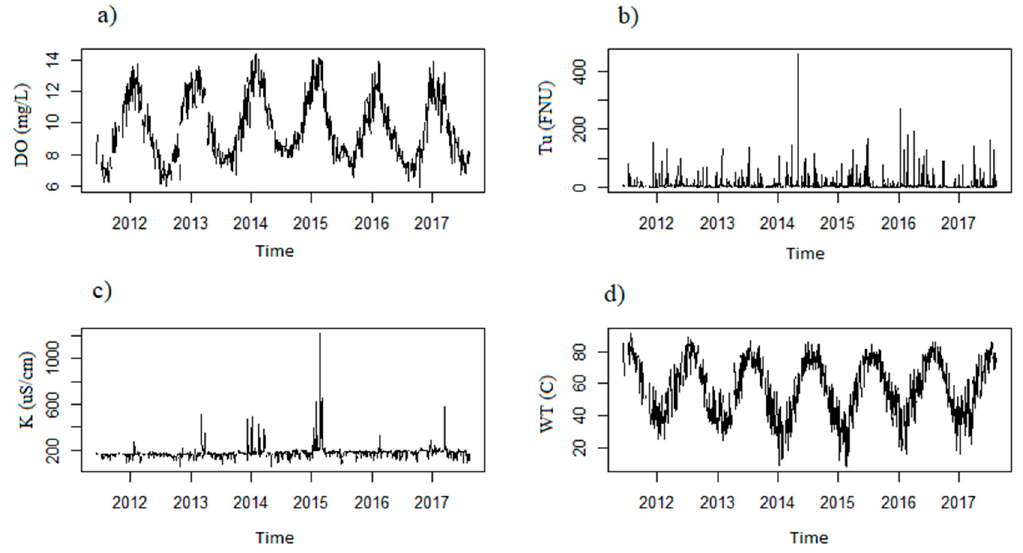
6 of 19 Figure 2. Methodology flowchart. The rectangular shapes represent data and the diamond shapes represent processes. 3.1. Data Pre-Processing Before applying the PCA and Granger causality analysis to the collected data, there are a few pre-processing steps that need to be considered. First off, missing observations in time series are very common and many methods are available to overcome this issue [29]. Many time series analysis techniques assume there is no gap in data frame, and the